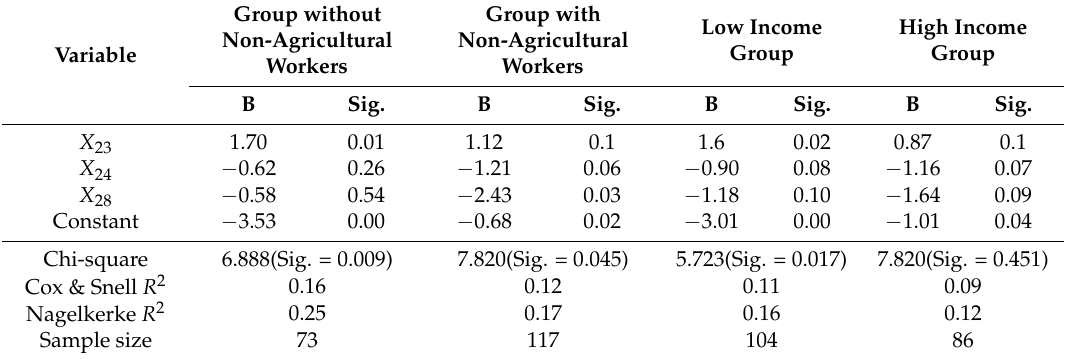
Table 5. Cluster analysis results of migration willingness of farmers classified according to family economic